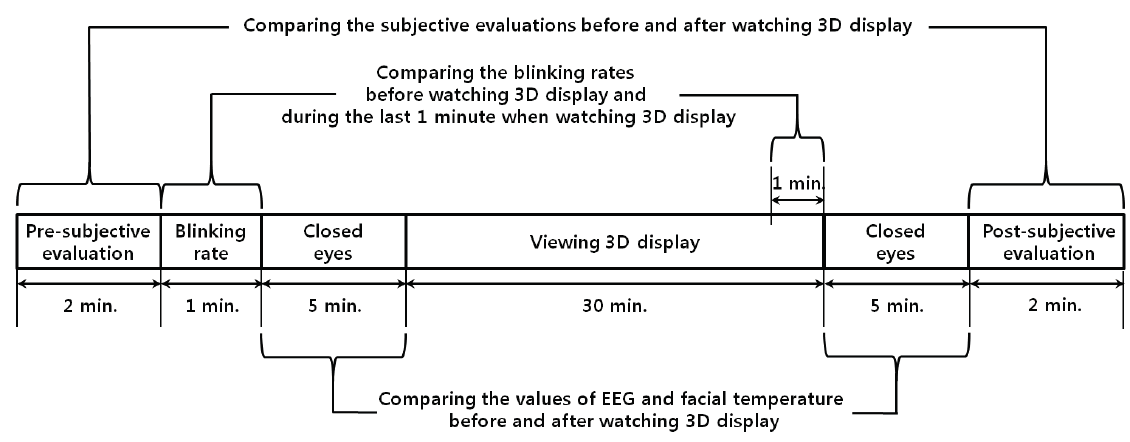
Figure 8. Experimental